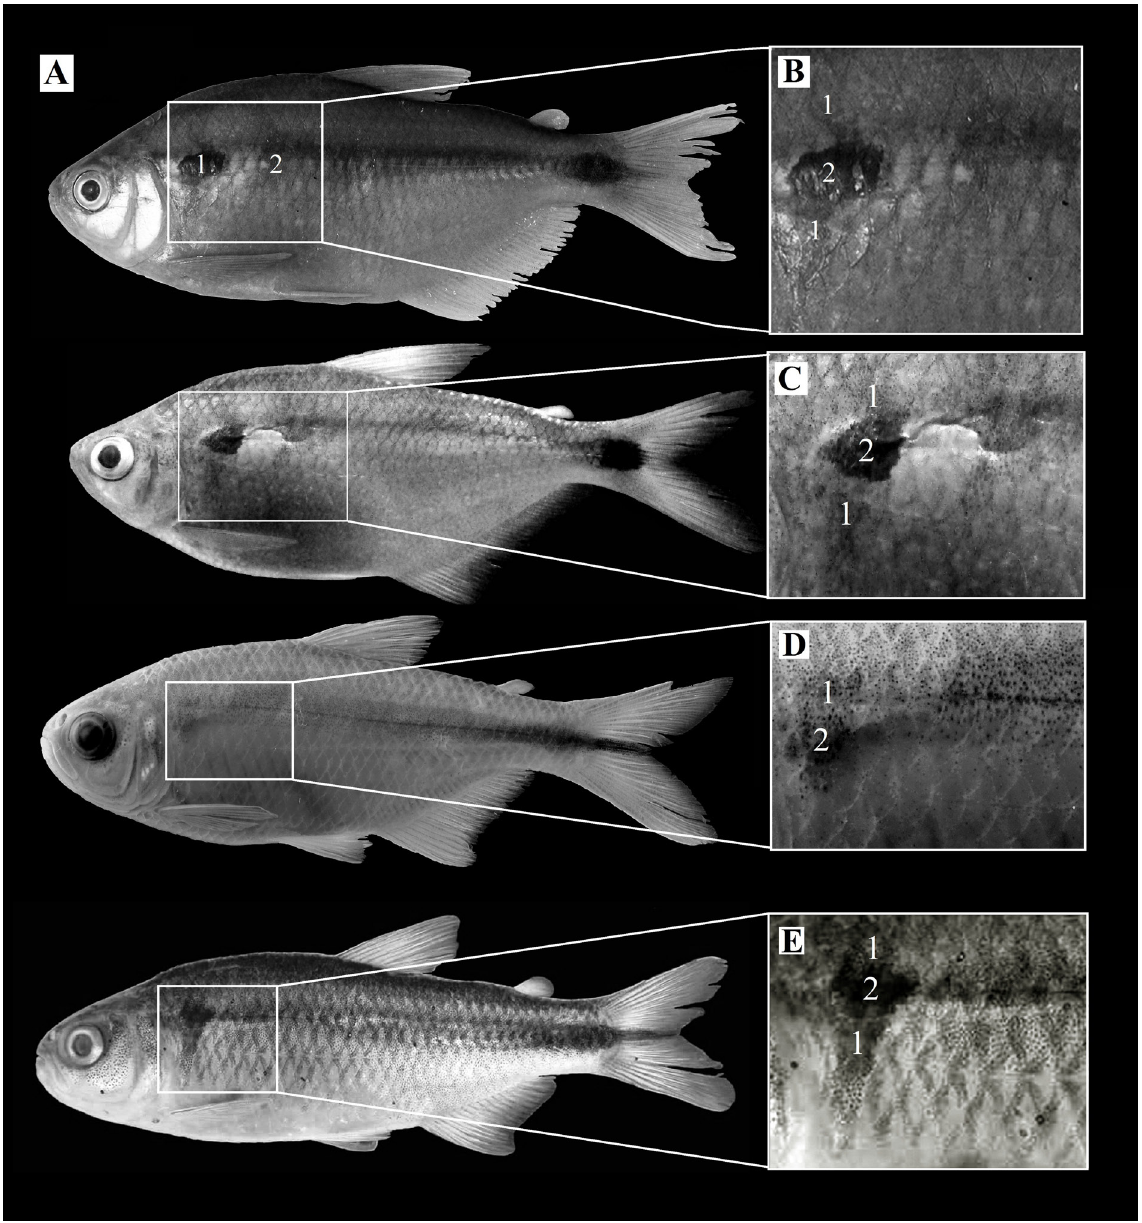
Fig. 1. A . Distribution of pigment in the humeral region of Astyanax species. B . A. bimaculatus ( Linnaeus, 1758 ) . C . A. caucanus (Steindachner, 1879) . D . A. mexicanus (De Filippi, 1853). E . A. courensis Bertaco, Carvalho & Jerep, 2010 ( modified from Bertaco et al. 2010 ) . The anterior humeral spot consists of two overlapping layers of pigment identified by numbers 1 and 2 (see Román-Valencia et al . 2015: fig. 1): 1 . Diffuse vertical bar. 2 . Horizontal spot with